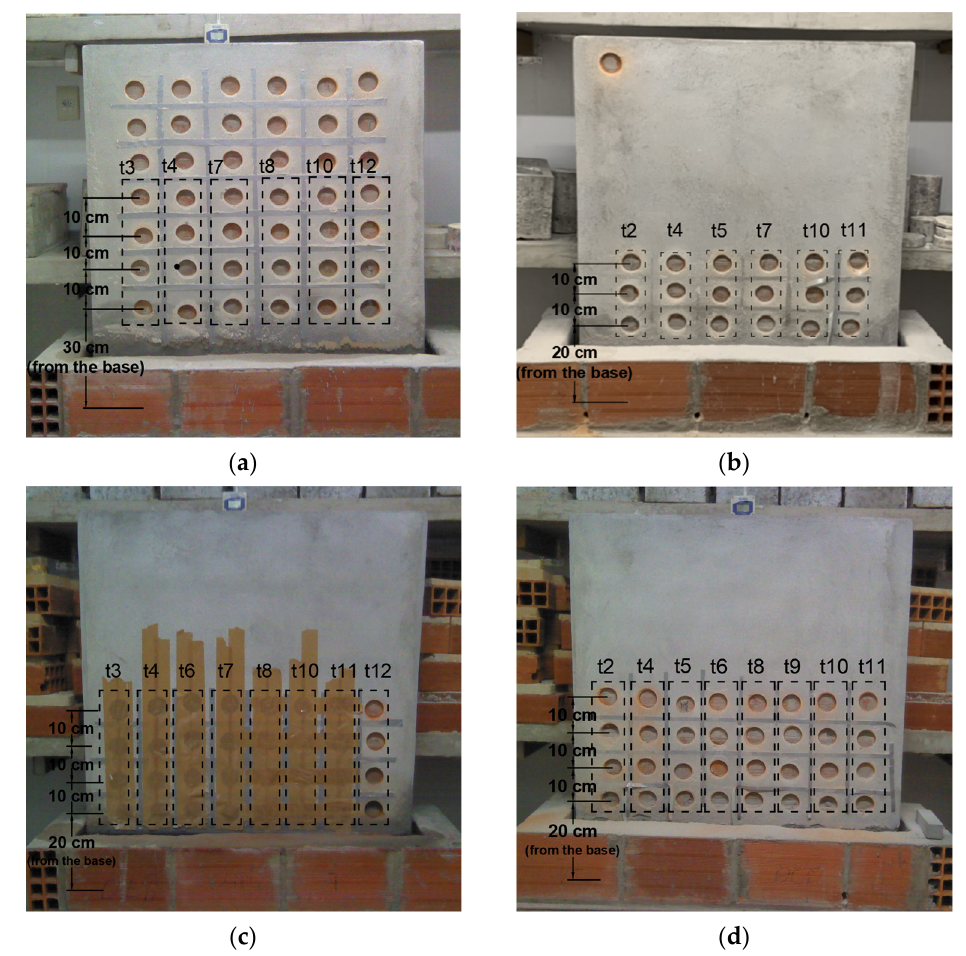
Figure 4. Measurement areas in the humidification and drying of the walls: ( a ) humidification—hot chamber; ( b ) drying—hot chamber; ( c ) humidification—cold chamber; ( d ) drying—cold chamber.